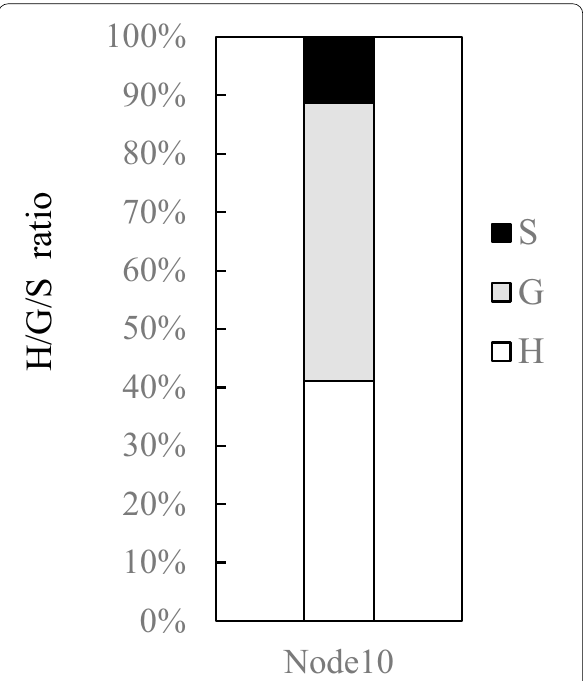
Fig. 8 H/G/S ratio of lignin of current year bamboo. H/G/S ratios of pyrolysis products of lignin of the current year bamboo. The